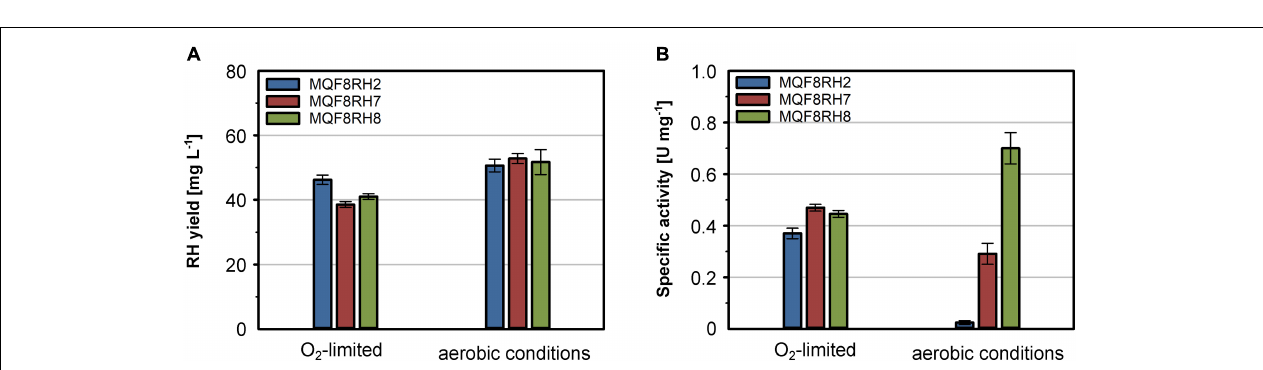
FIGURE 5 | Metal effect on soluble RH yield and activity. E. coli strain MQF8RH3 was cultivated in 125 mL PreSens flasks with 50 mL boosted EnPresso B medium at 18 ◦ C. The medium was supplemented with different molar ratios of NiCl 2 and FeSO 4 as indicated. (A) RH protein was purified by affinity chromatography, and the yield was quantified. (B) Specific activities measured from the purified RH samples.